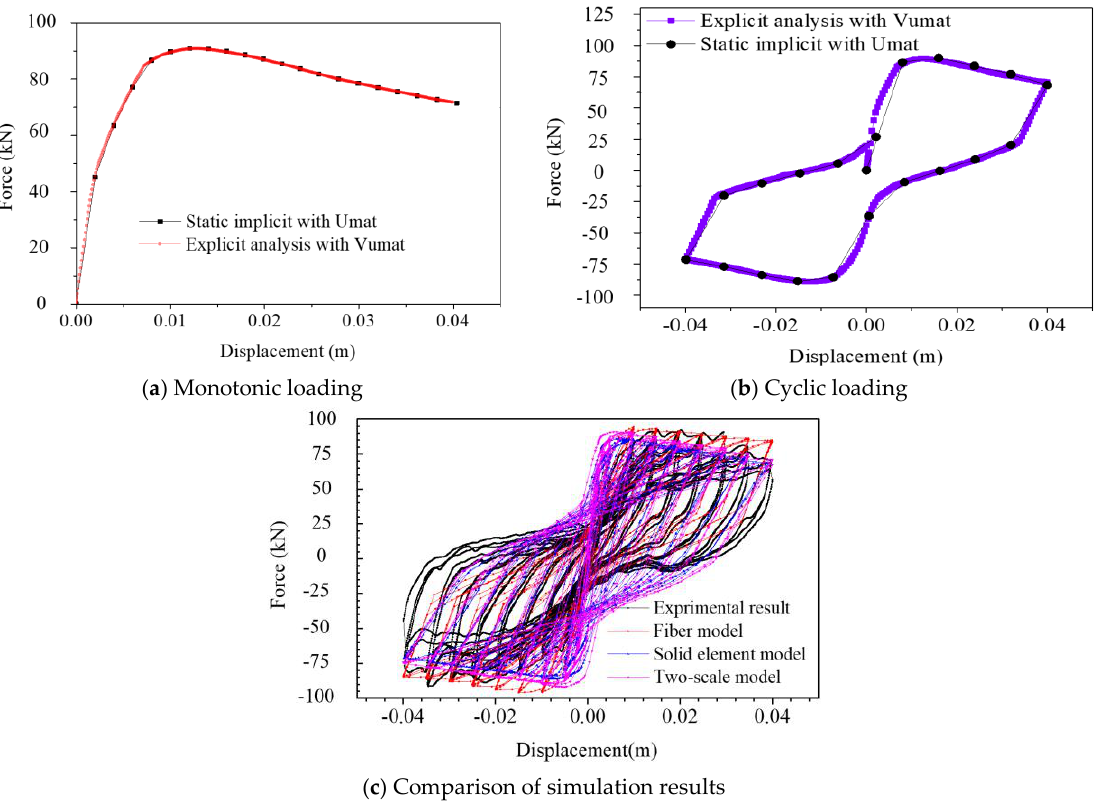
Figure 7. Verification of material subroutines and simulation results with different modeling techniques